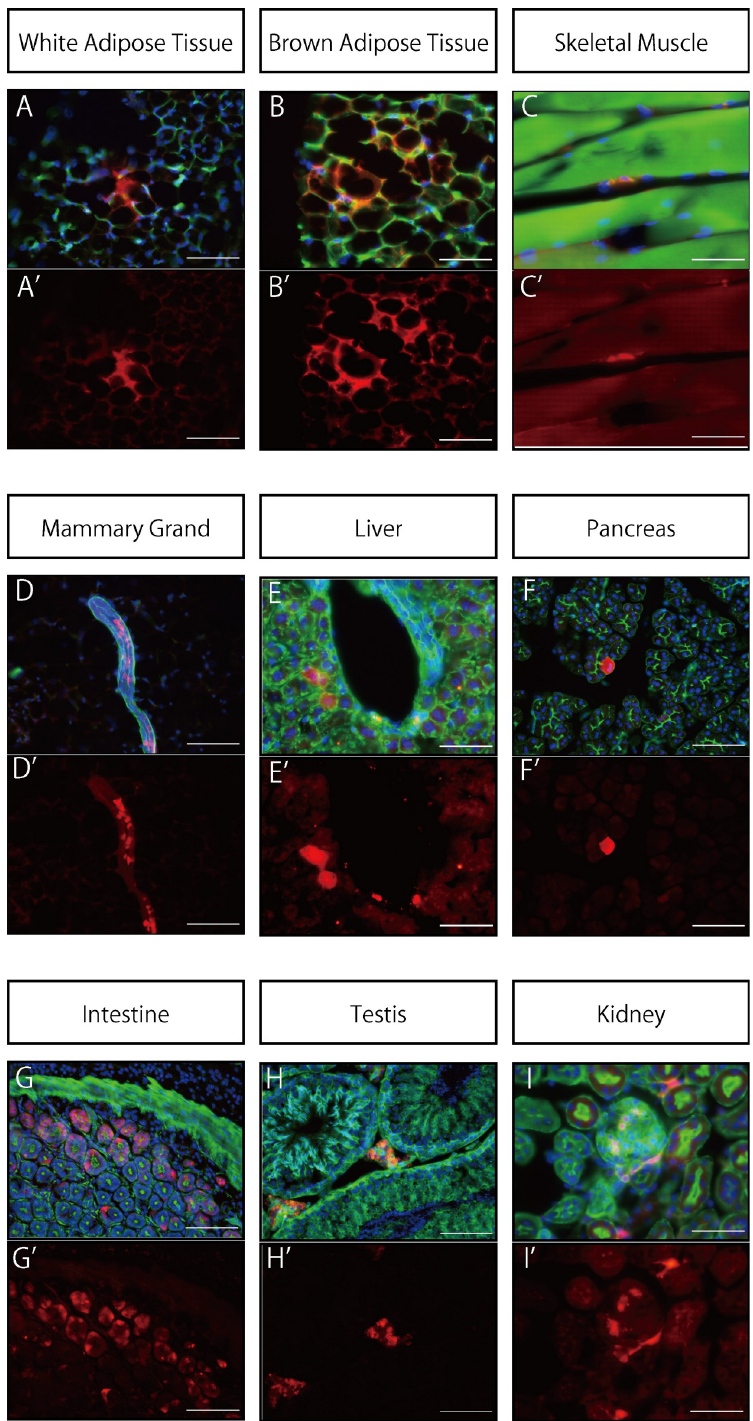
Fig 2. Expression distribution of Meflin lineage cells in vivo. Organ tissues from Meflin -CreER T2 /Rosa26-tdTomato mice treated with tamoxifen beginning at 6 weeks of age and fed a normal diet for 4 weeks were analyzed histologically. Nuclei were stained using DAPI (blue); staining with the F-actin marker phalloidin (green) was used to define the cytoskeleton. The tdTomato signal (red) was found in gonadal white (A) and brown (B) adipocytes. In skeletal muscle (C), mammary ducts (D), liver (E), testes (H), and kidneys (I), tdTomato expression was found in cells located in the interstitium. In the pancreas, expression was observed in glandular cells (F); expression in the kidneys was seen in cells